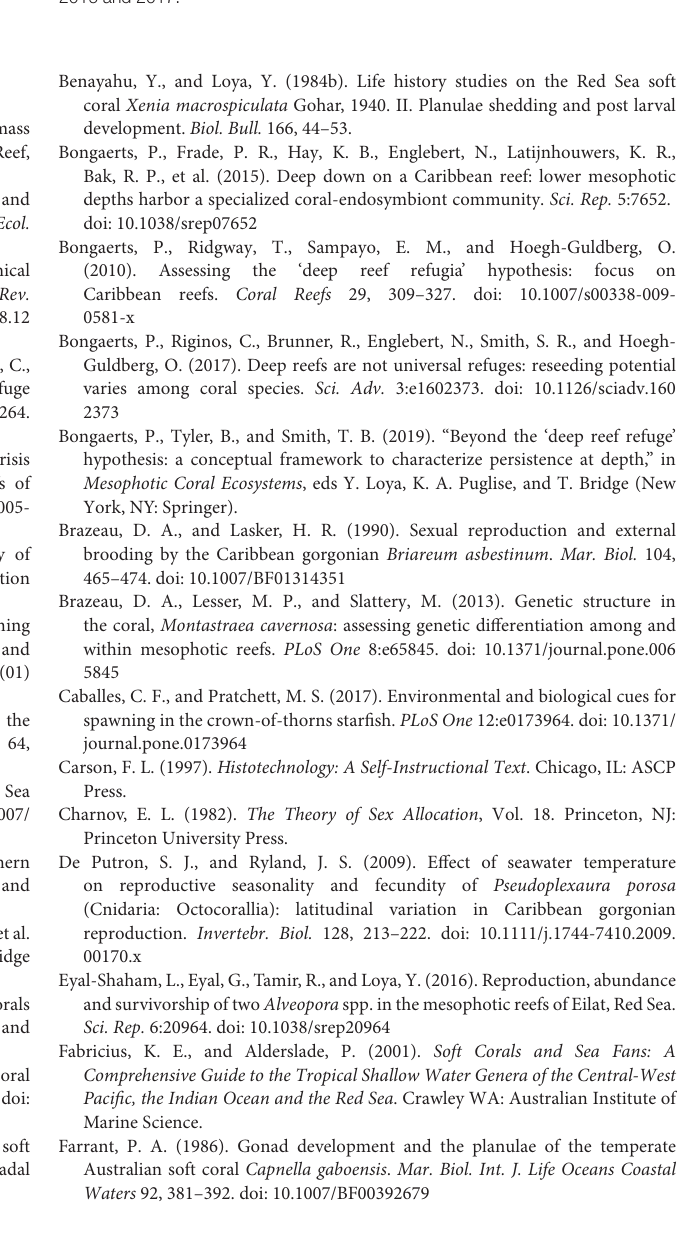
FIGURE S1 | Mean daily temperature curves during June-July 2016 representing both depth-zones: upper MCE (orange) and shallow-reef zone (blue) with indication of lunar phase. Timing of Rhytisma fulvum fulvum surface-brooding events are indicated in gray: upper MCE (gray-orange) and shallow-reef